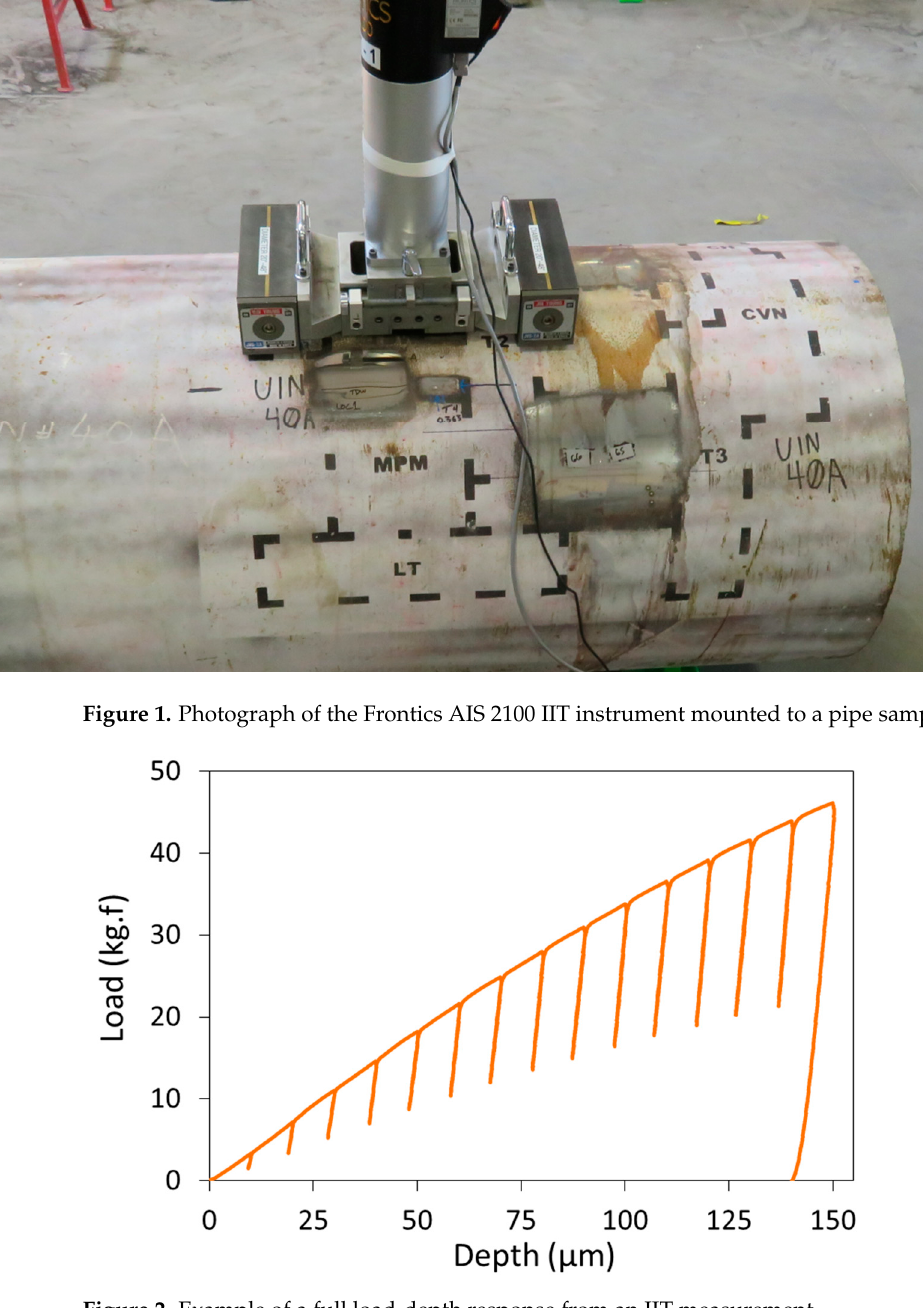
Figure 2. Example of a full load-depth response from an IIT measurement.